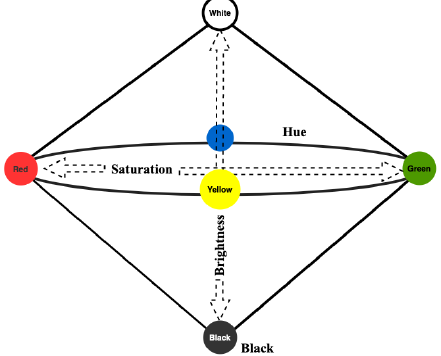
Figure 2. The color space